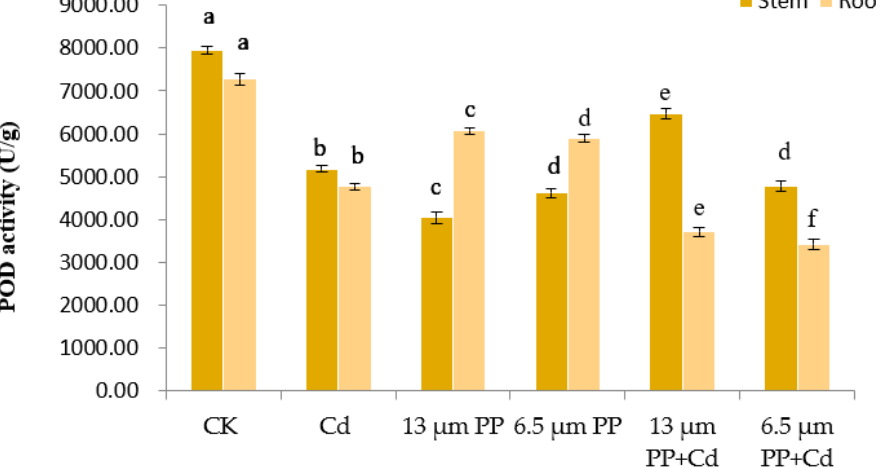
Figure 5. Effect of PP MPs and Cd on peroxidase activity (POD) of rice seedlings. Results are shown in mean ± SD ( n = 9). Different lowercase letters a, b, c, d, e and f represent a significant difference between different treatments groups at the same MP particle size or at the same cadmium concentration (at p ≤ 0.05), whereas the same letters indicate insignificant differences between treatments. Where CK—Control check; Cd—Cadmium;